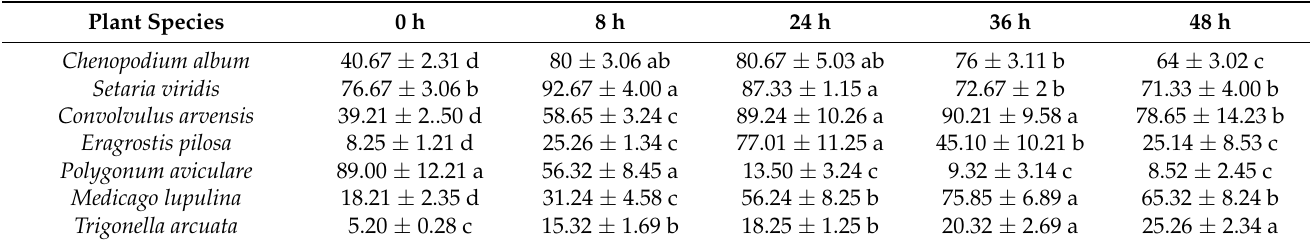
Table 5. Germination behavior of exotic plant seeds after rumen digestion in